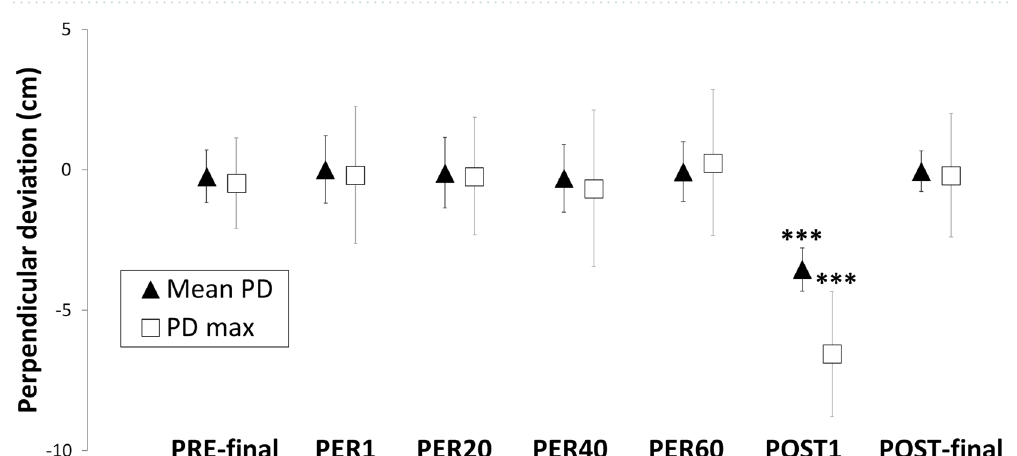
Figure 5. Perpendicular deviation of the trajectory from a straight-line linking start and end locations, as a function of the experimental Phase. Vertical bars represent standard deviation around the mean across participants. Stars indicate significant differences of mean and maximum perpendicular deviation in POST1 compared with all other phases (***p <